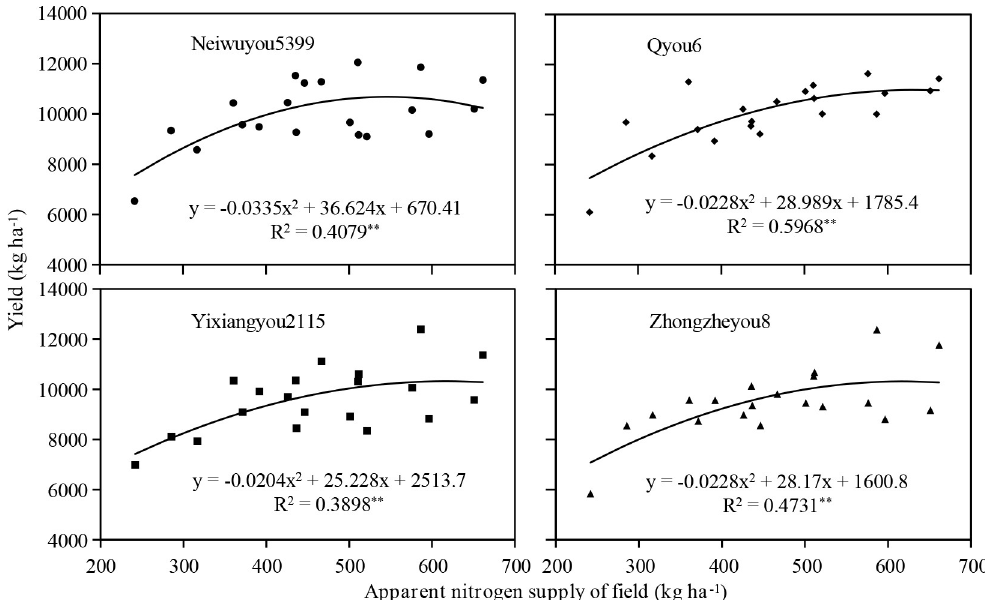
Fig 1. Curve fitting between the apparent N supply (N x ) and yield at heading. �� indicates extremely significant correlation at 0.01 probability level. Nx is the sum of the Nt (kg ha − 1) and Ng. Nt is the product of alkali-hydrol N and soil density (2.25 × 10 6 kg ha − 1 ).